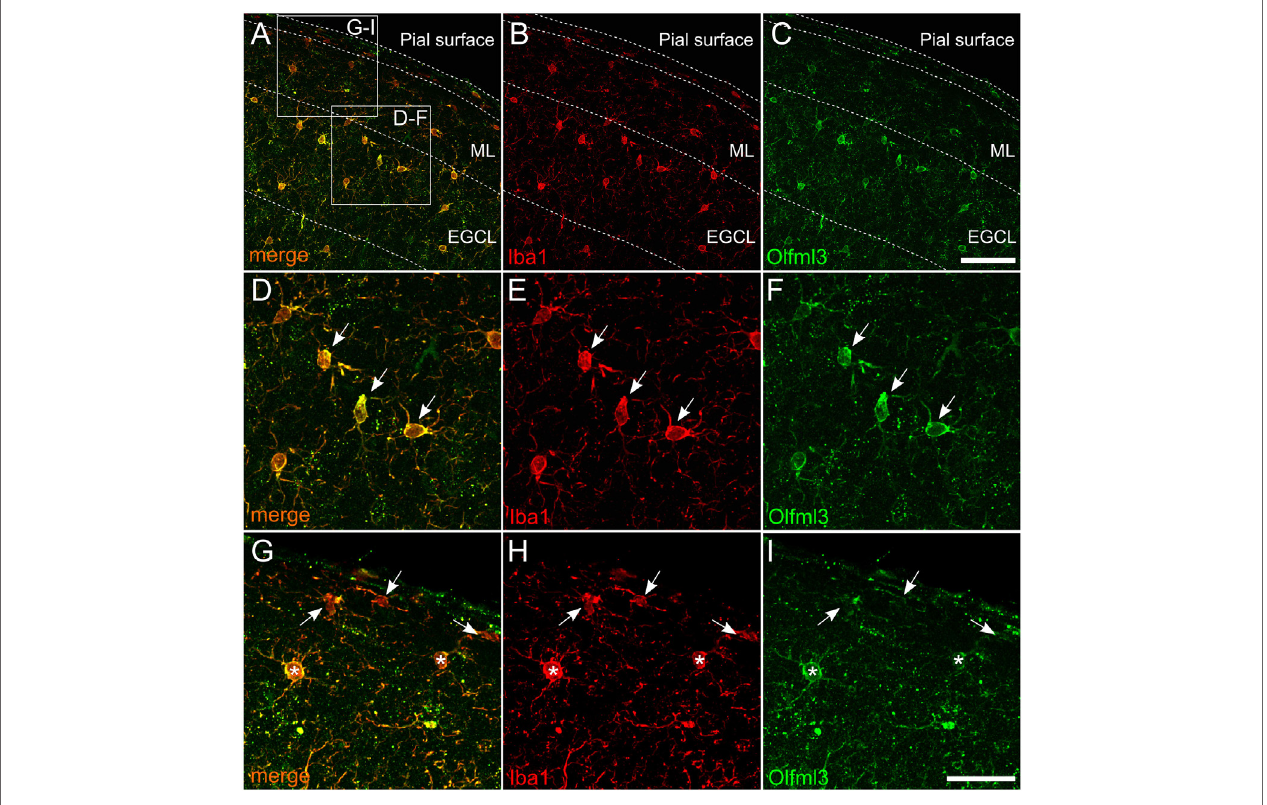
FigUre 2 | Expression of Olfml3 in cortical microglia. Overlay (a) of Iba1 + (B) and Olfml3 + (c) cortical microglia from 6-month-old C57BL/6 mice demonstrate microglia-specific expression of Olfml3. White arrows in high magnification images show strong cytoplasmic immunoreactivity for Olfml3 (F) in Iba1 + microglia (D,e) . Noteworthy, Iba1 + meningeal macrophages (white arrows) located in close proximity to the pial surface show faint Olfml3 expression as compared to microglia (white asterisks) of the ML (g–i) . Abbreviations: ML, molecular layer; EGCL, external granule cell layer. Scale bars represent 20 µm (a–c) and 10 µm (D–i)